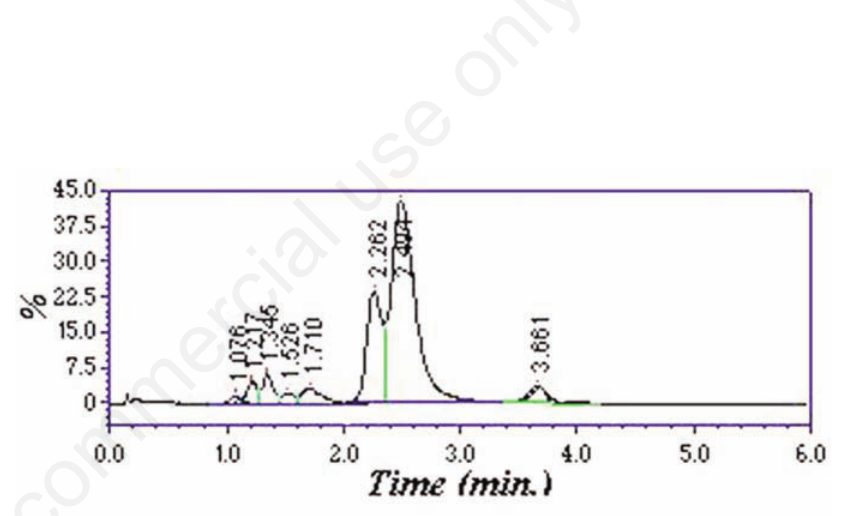
Figure 2. High-pressure liquid chromatography chromatogram.